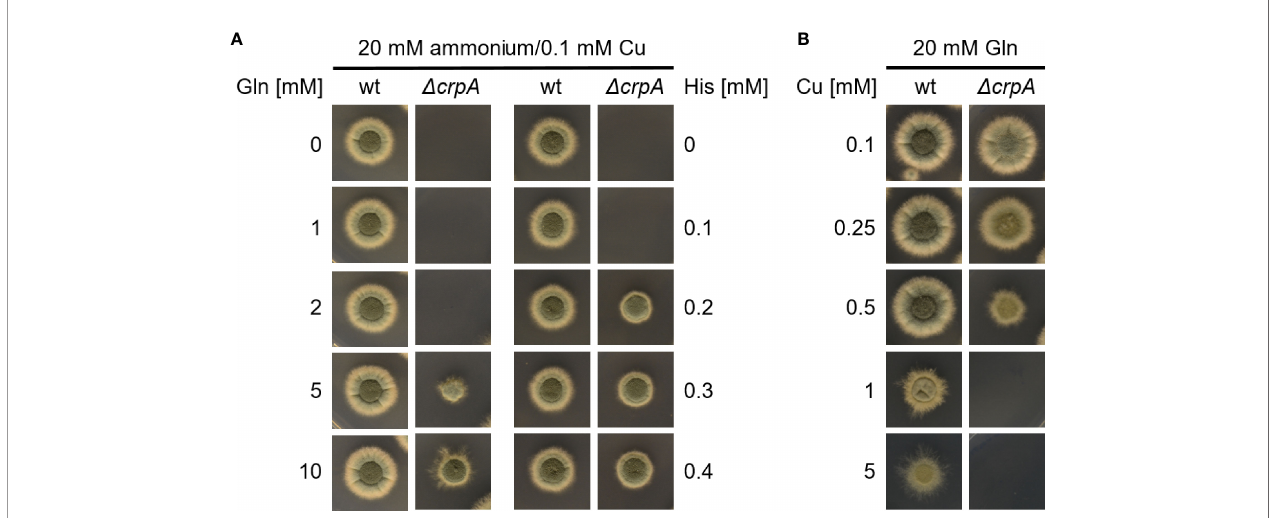
FIGURE 3 | Supplementation with His protects A. fumigatus D crpA against Cu toxicity to a higher degree compared to Gln. A. fumigatus wt and D crpA conidia were point-inoculated on solid AMM. (A) The growth medium contained 20 mM ammonium as nitrogen source, 0.1 mM Cu, and different concentrations of either Gln (left) or His (right). The plate assay without Gln (0 mM Gln) is the same as the one without His (0 mM His). (B) The growth medium contained 20 mM Gln as nitrogen source and different concentrations of Cu.